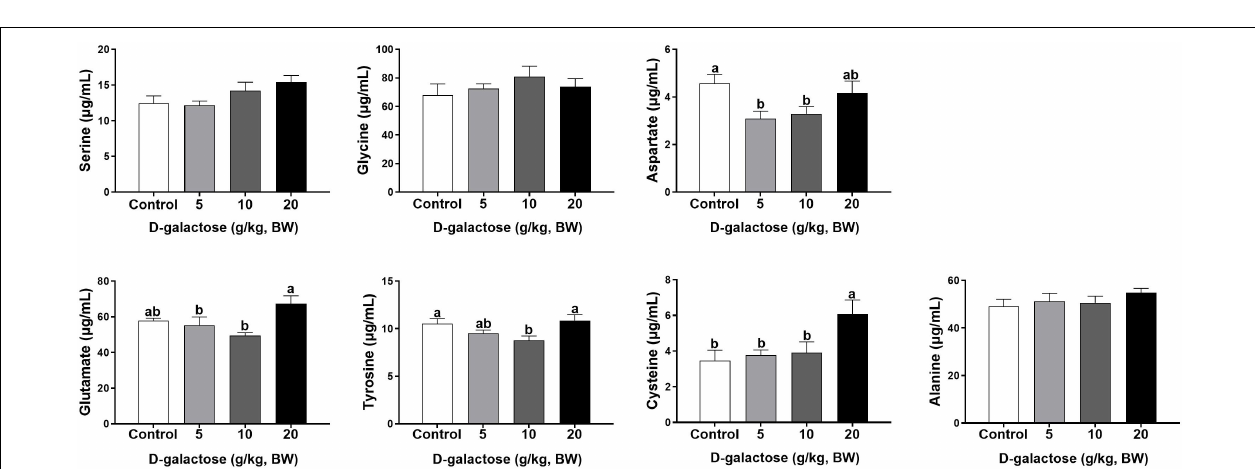
FIGURE 4 | Effects of D -galactose on essential amino acids in the serum at the first week. Data were expressed as the mean ± SEM. Different lower-case letters indicate a significant difference among different dosage of D -galactose ( P < 0.05).